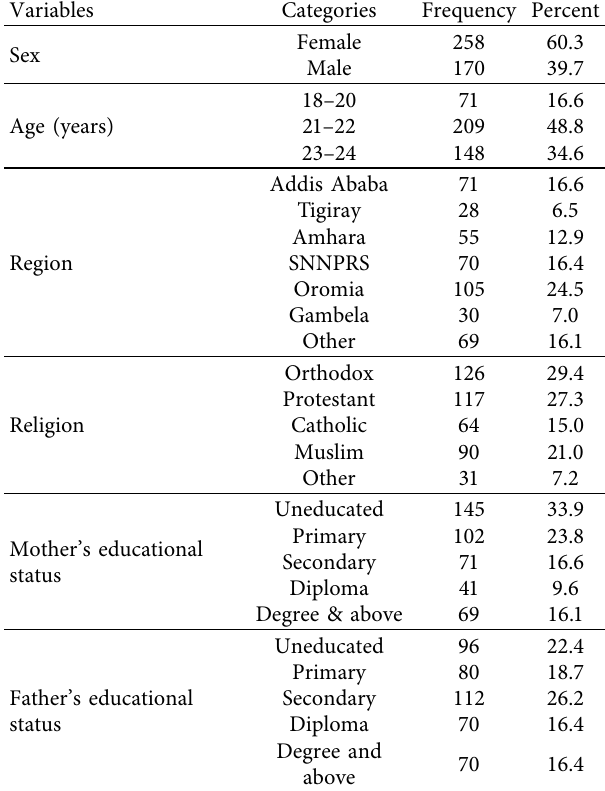
Table 1: Sociodemographic characteristics and family background of students, 2019 ( n �